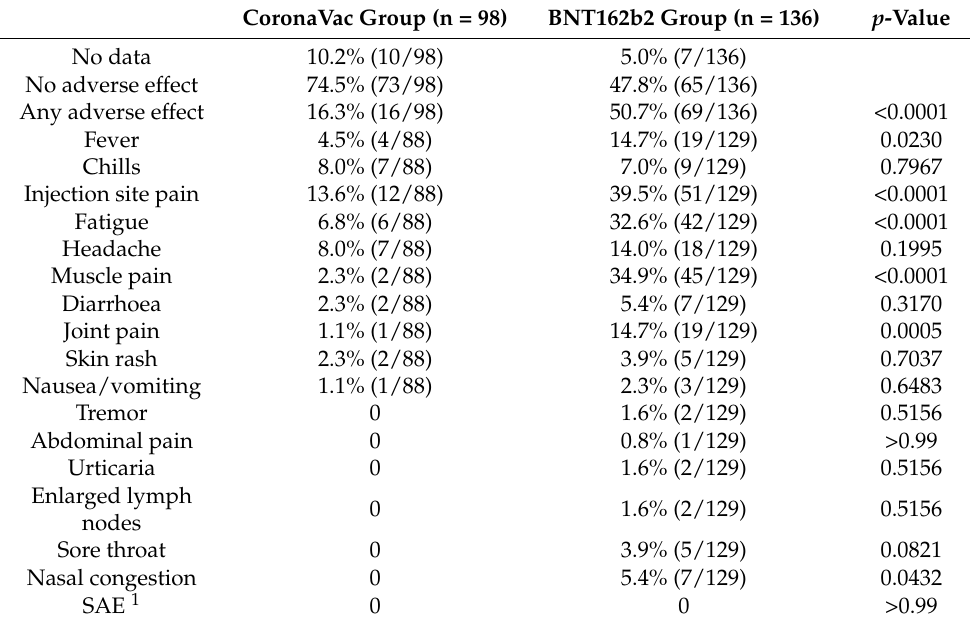
Table 5. Adverse effects of CoronaVac and the BNT162b2 booster 1